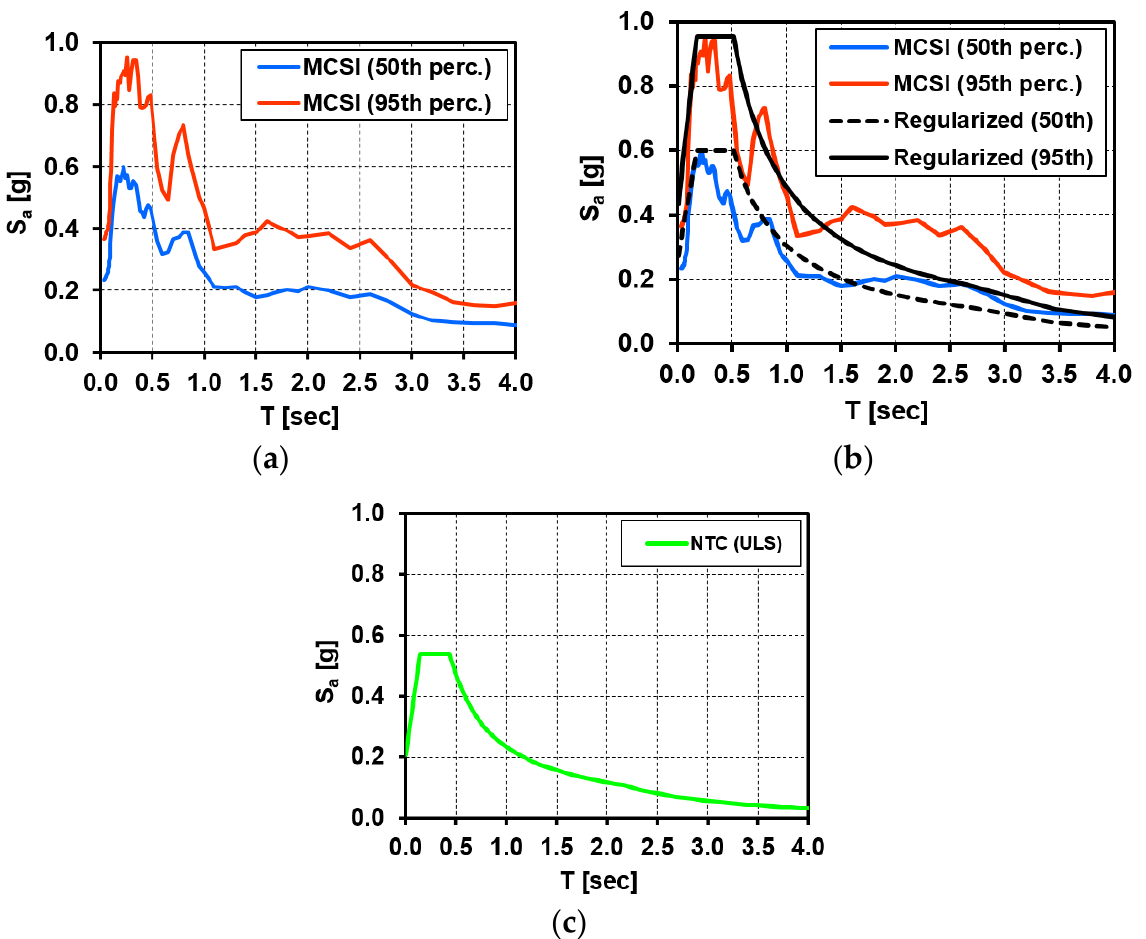
Figure 13. MCSI spectra at ( a ) the 50th and 95th percentile, ( b ) regularization response spectra, and ( c ) design response spectrum for the Mirandola site.